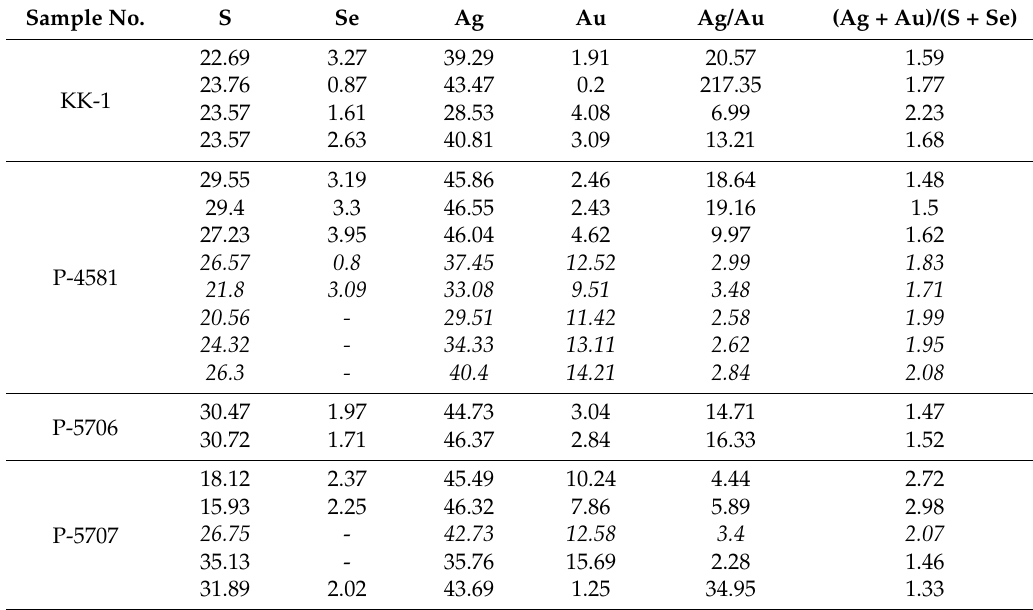
Table 6. SEM-EDX data of sulfur, selenium, silver, and gold contents (at %) and their ratios in the sectors of native gold enriched with sulfur (from the Kvartsevaya Sopka deposit). Sample No.